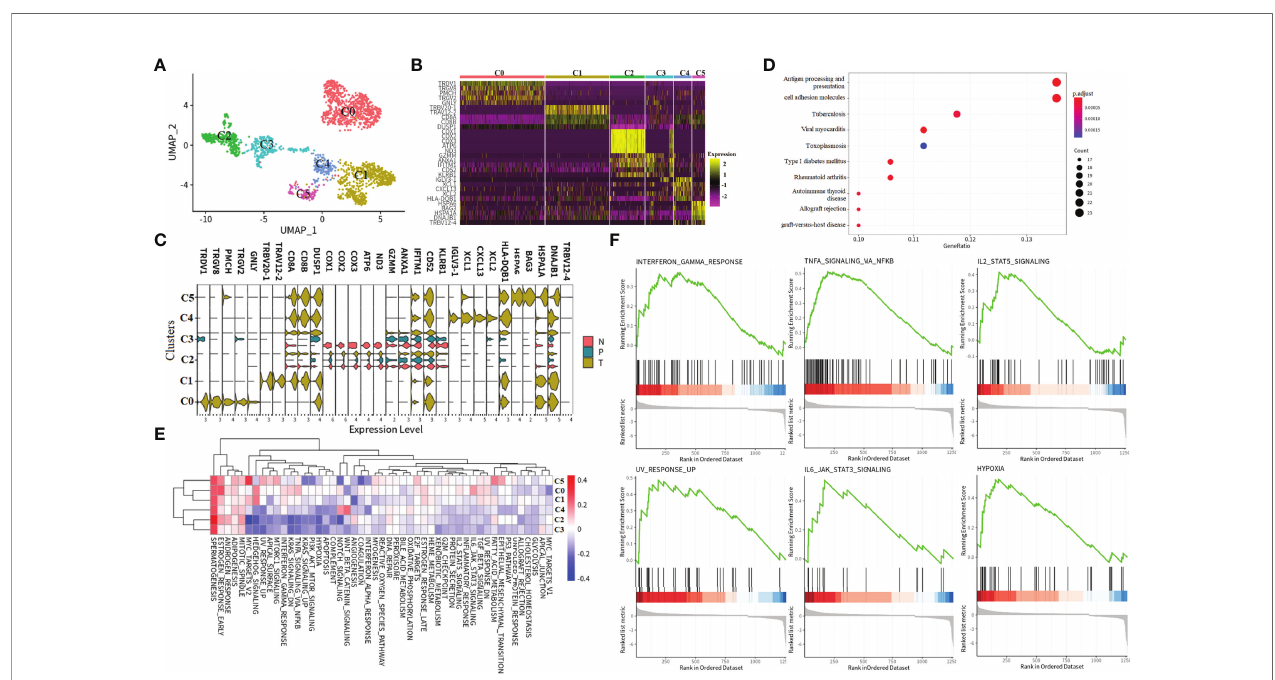
FIGURE 4 | Subtypes and immune response characters of CD8+ T_2 cells. (A) UMAP visualization of the CD8+ T_2 subtype. Each dot corresponds to a single cell, colored according to cell subtype. (B, C) Heatmap of selected markers for CD8+ T_2 subcluster and visualization of the expression level of selected markers in each tissue type. “ N ” indicates tumor in matched adjacent normal tissue, “ T ” means renal tumor tissue, and “ P ” represents peripheral blood. (D) KEGG pathway enrichment analysis of the CD8+ T_2 subtype. The points size indicates the counts of genes enriched in a speci fi c pathway, and the color means the statistical signi fi cance. (E) GSVA enrichment visualization of the CD8+ T_2 subtype. The red color indicates that the speci fi c pathway is upregulated in a subtype, and the blue color means the pathway is downregulated. (F) GSEA pathway enrichment visualization of differentially expressed genes in tumor tissue compared to adjacent normal tissue in the CD8+ T_2 subtype. All six pathways are upregulated in renal tumor